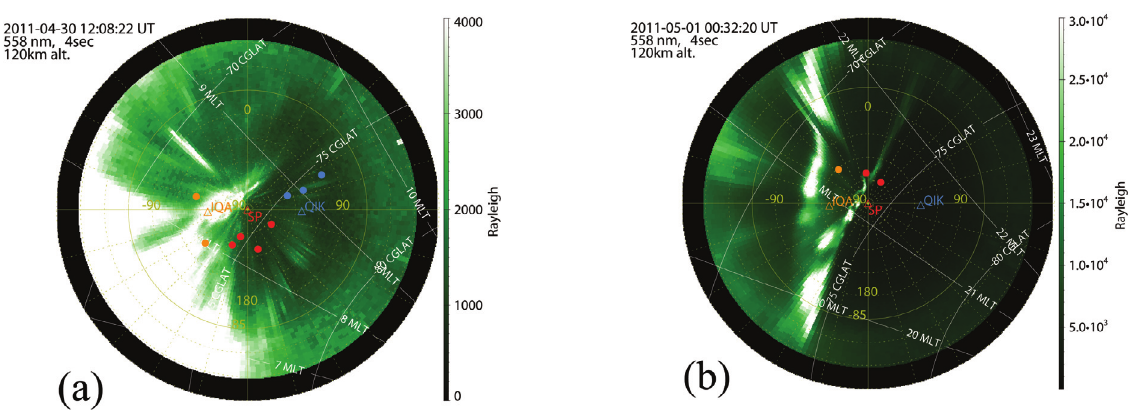
Figure 7. The 557.7-nm images of (a) a corona display in the morning sector on April 30, and (b) pre-midnight pseudo-break-up of an arc on May 1,